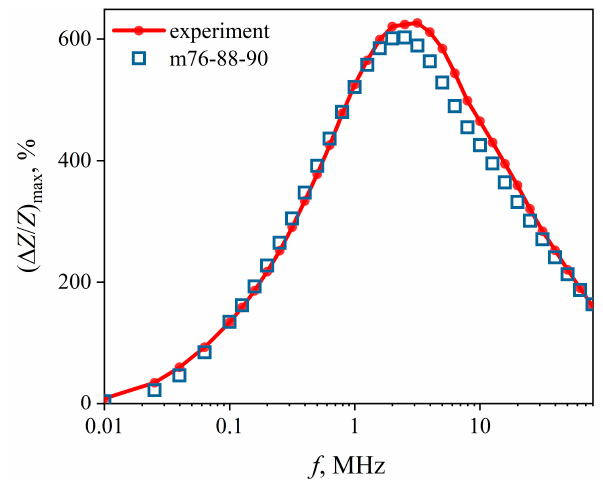
Figure 8. MI behavior for an amorphous Co 66 Fe 4 Nb 2.5 Si 12.5 B 15 wire. The line with round markers shows the dependences of the magnetoimpedance effect on the strength of the external magnetic field Δ Z/Z ( H ), obtained at AC frequencies: ( a ) 1 MHz, ( b ) 10 MHz, ( c ) 40 MHz, and ( d ) 80 MHz. The insets show the same dependences in the range of the magnetic fields from –12 to 12 kA/m. Square markers are data obtained using the m76-87-90 model.